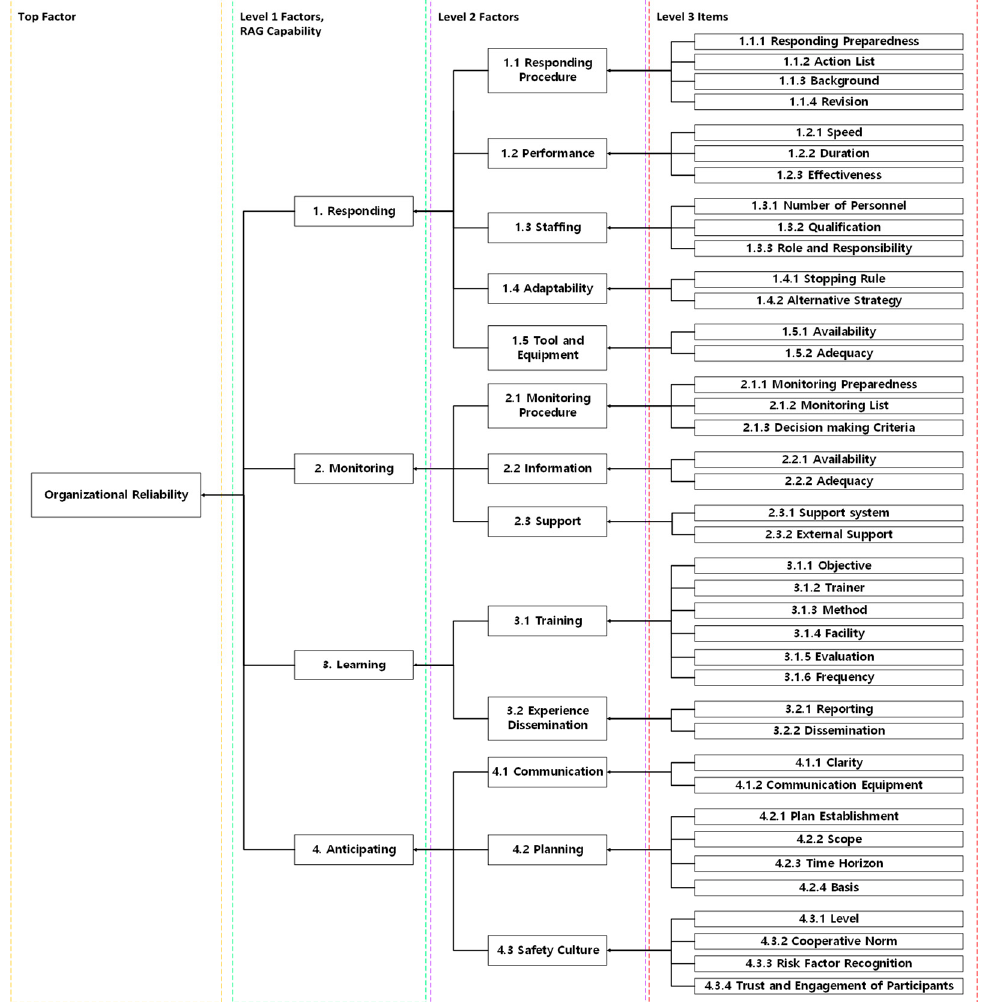
Figure 2. Structure of contributing factors to ERO. Table 8. Definitions and contributing factors for responding